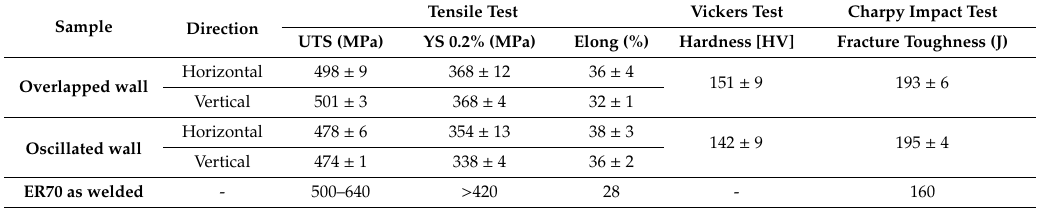
Figure 13. The stress–strain curve and ultimate tensile strength (UTS), yield strength (YS) and elongation percentage (Elong . ) calculation on each test specimen in ( a ) horizontal direction and ( b ) vertical direction . Table 5. Summary comparison of mechanical characterization on the overlapping and oscillating